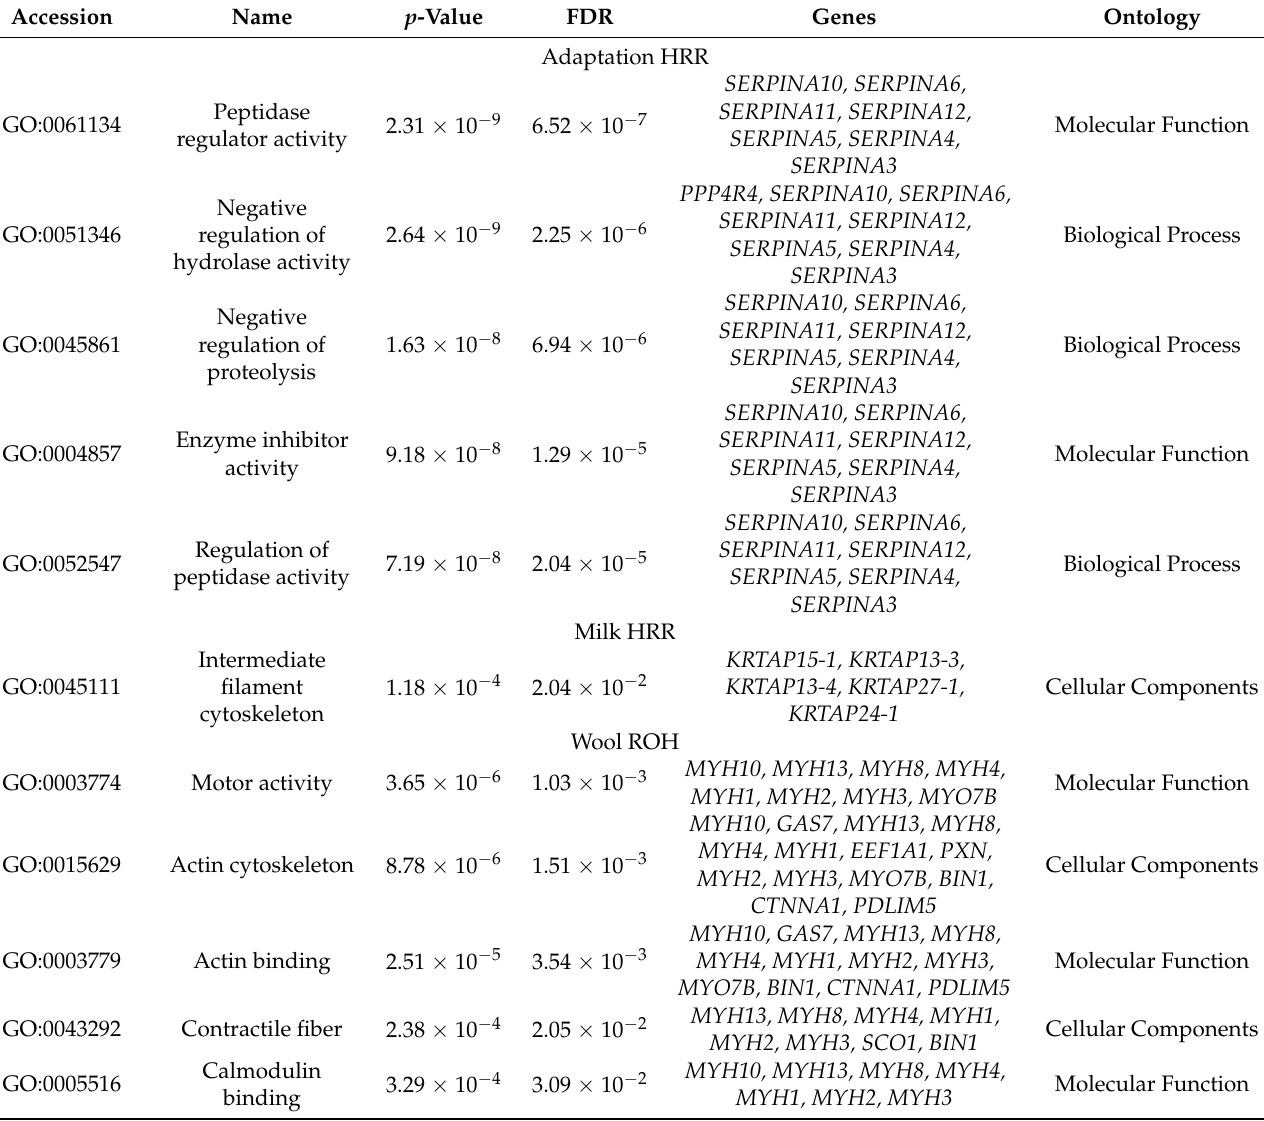
Table 4. Gene ontology (GO)-enriched terms and the respective types of island where associated genes were